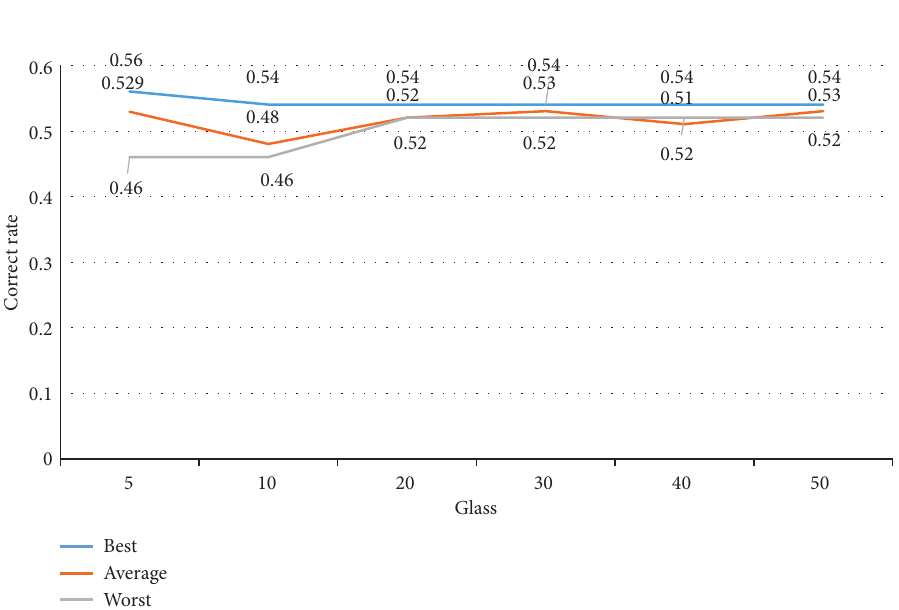
Figure 7: The influence of remote sensing image clustering algorithm.